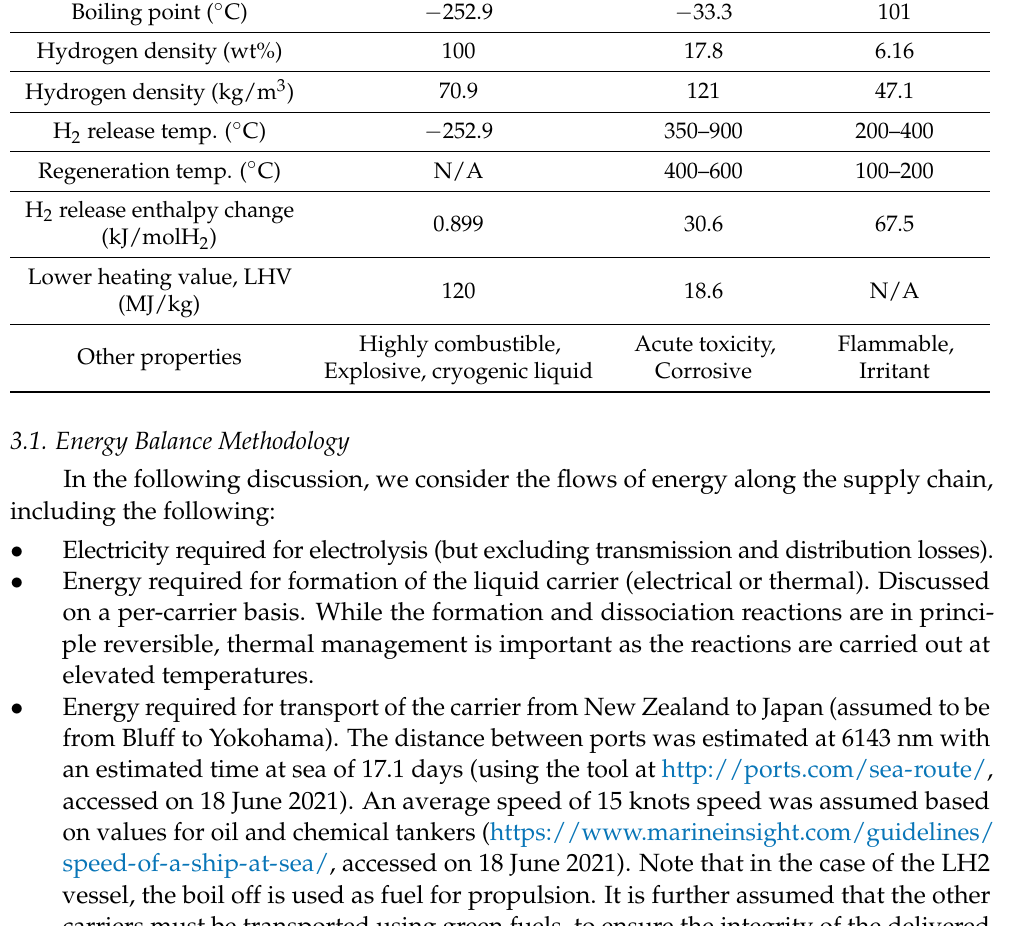
Table 2. Properties and characteristics of the prominent potential hydrogen carriers [23–26].